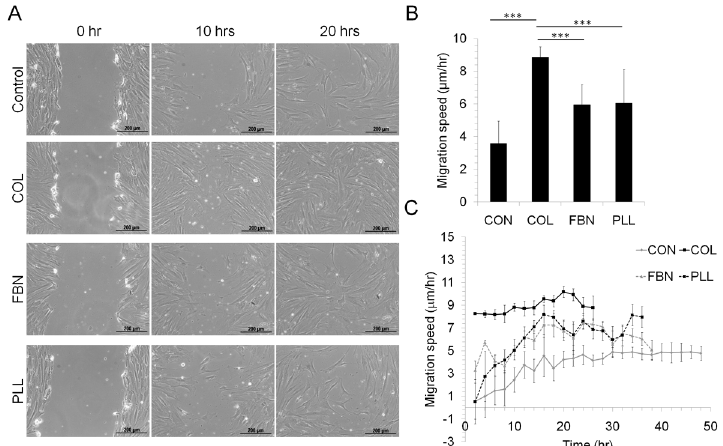
Fig 3. Cell migration analysis. MSC were seeded on different matrices (Control, COL, FBN, PLL) and cultured until confluence. The cells were serum starved for 24 hours to inhibit cell proliferation and a scratch was made in the confluent layer. (A) The cell migration was documented microscopically at regular time intervals (~2 hours) and the distance covered by the cells on each matrix was calculated and the average migration speed determined. (B) Average migration speed was calculated from three independent experiments and values are plotted. Values are Mean ± SD, n = 3. (C) MSC migration on different matrices was determined by wound healing assay. MSC were seeded on control TC treated surface (CON), COL, FBN or PLL coated surface and the migration speed was analysed every 2 hours until the wound closed. Values are Mean+SEM, n = 3 independent experiments. *** p <